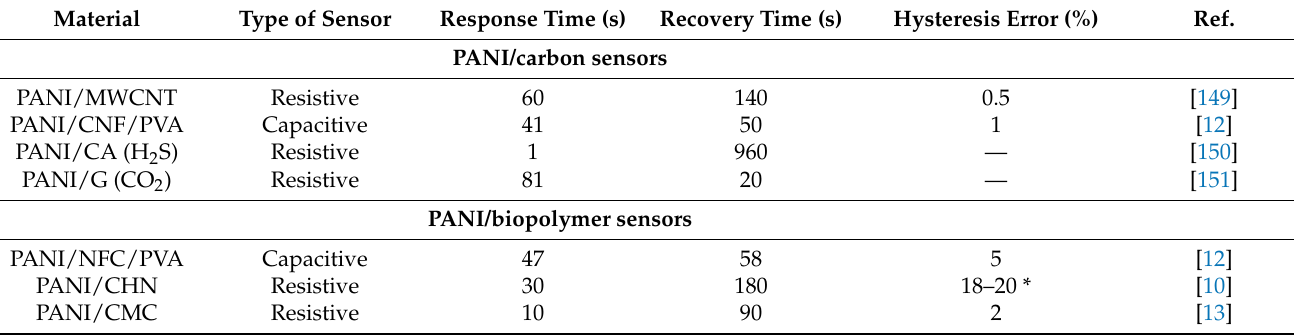
Table 6. Comparative features of carbon- and biopolymer-based sensors.